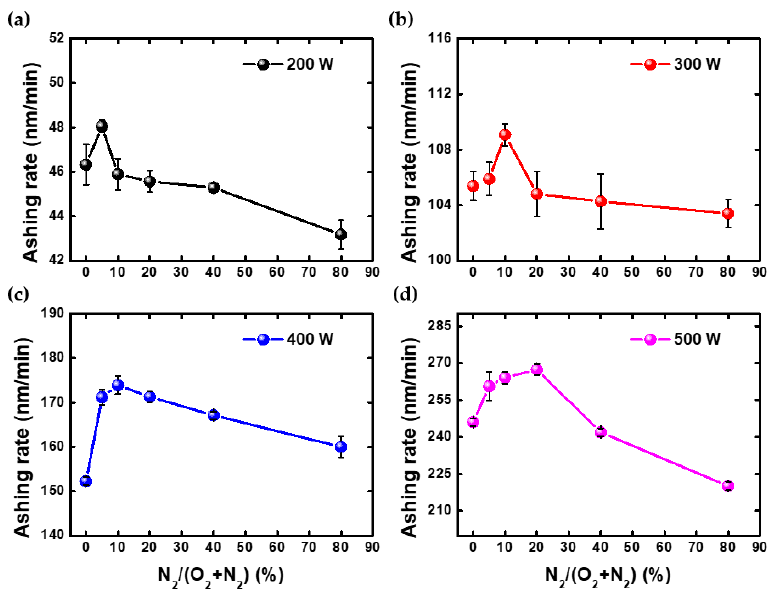
Figure 3. This is the ashing rate as N 2 /(O 2 + N 2 ) ratio at ( a ) 200 W, ( b ) 300 W, ( c ) 400 W, and ( d ) 500